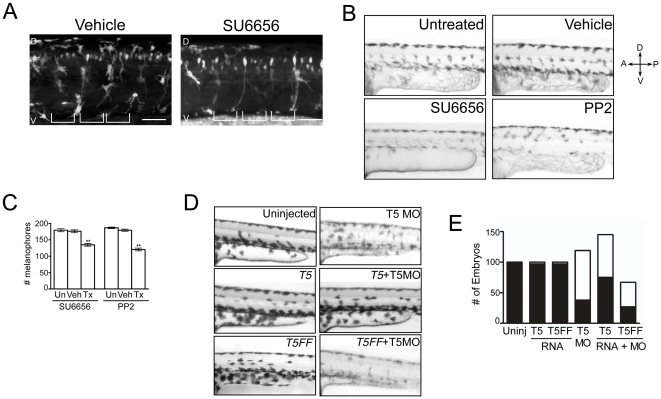
Neural crest derivatives require a Src-Tks5-dependent pathway in vivo.(A) Tg(sox10:RFP) embryos (8 hpf) were treated with either vehicle (DMSO) or SU6656 for 24 hours and imaged by confocal microscopy to detect neural crest cells. (D = dorsal, V = ventral). Brackets indicate the position of the somites. Scale bar represents 50 µm. (B–C) Embryos at 15 hpf were treated as indicated for 24 hours and analyzed for pigmentation defects. (B) Embryos where treatment was initiated at 15 hpf were examined for melanophore patterning in the trunk region above the yolk sac extension. (D = dorsal, V = ventral, A = anterior, P = posterior) (C) The total number of melanophores present in the dorsal and ventral pigment lines was counted for embryos within each group as described in Materials and Methods. Mean values (n = 3) and SEM were shown in graph. ** denotes p<0.01 for vehicle treated vs. SFK treated comparison. (D–E) Embryos were injected as indicated and qualitatively analyzed for defects described previously. Morpholino and RNA concentrations detailed in Materials and Methods. (E) Morphants were identified as described in Figure 1D and embryos within each group were quantified (white = morphants, black = normal).